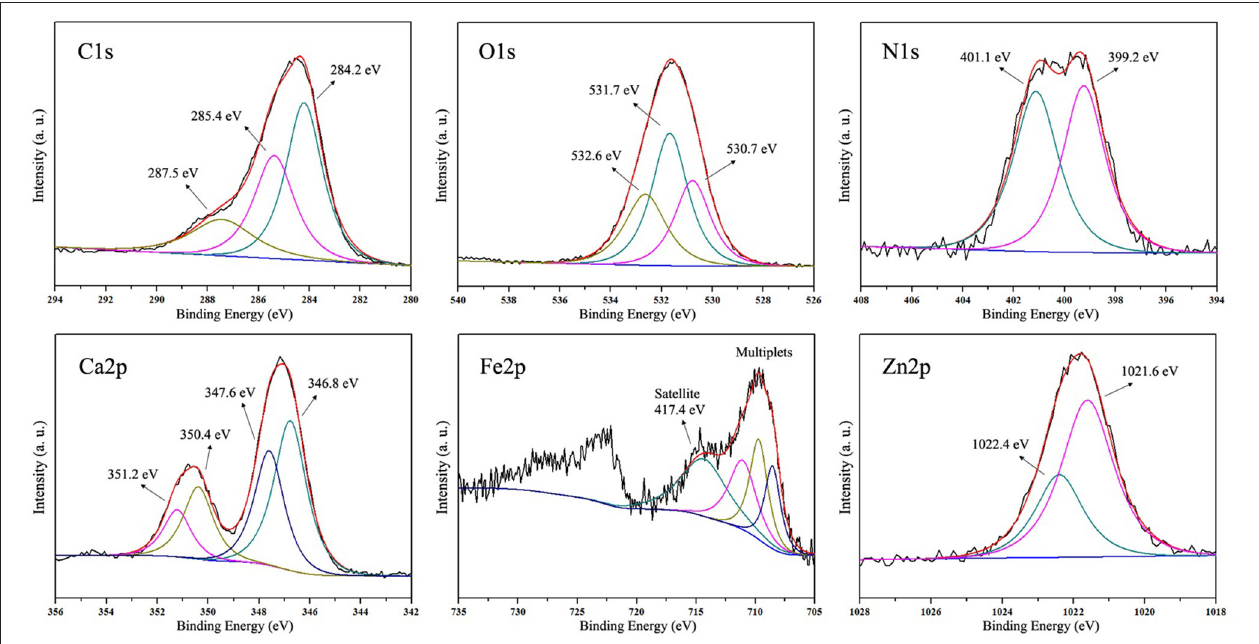
FIGURE 6 | Thermogravimetric (TG) plots of MRPs, MRPs–Ca, MRPs–Fe, MRPs–Zn, and MRPs–Ca/Fe/Zn.